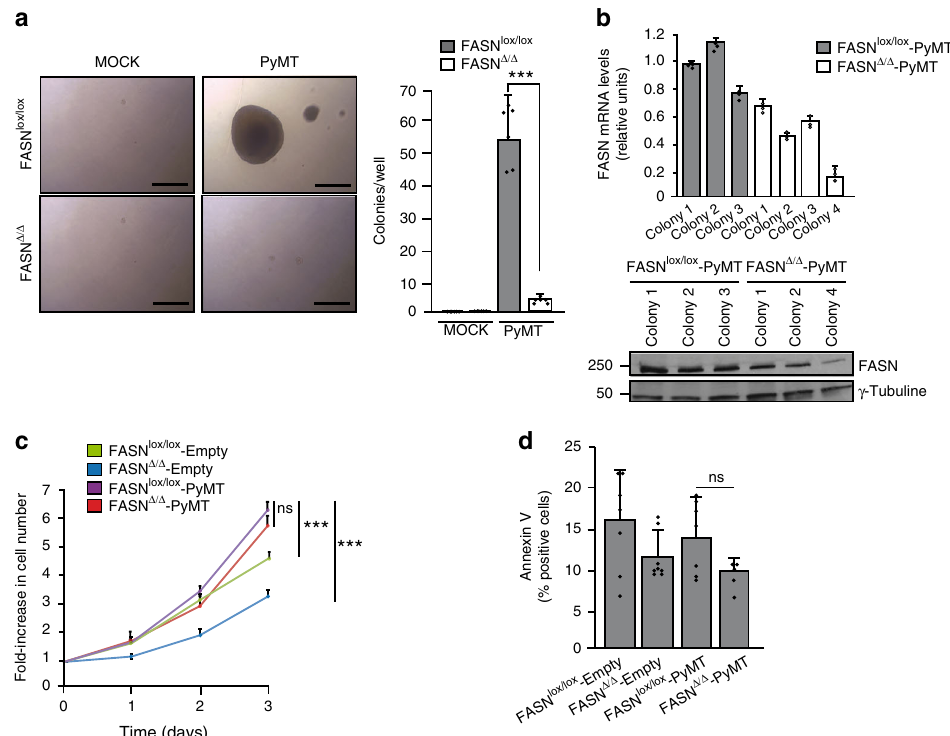
Fig. 1 FASN is essential for PyMT-dependent transformation in vitro. a Representative images of the soft agar colony assay and quantitation of colonies per well recovered from each of the four genotypes ( n = 6 biological replicates for each genotype). Scale bars, 500 μ M. b FASN mRNA and protein levels detected in soft agar colonies recovered from the FASN lox/lox -PyMT and FASN Δ / Δ -PyMT MEFs, respectively. c Cell replication rates after 1, 2, or 3 days for each genotype ( n = 3). Presented data are the mean values ± standard deviation (SD). *** P < 0.001; n.s., not statistically signi fi cant; Student ’ s t test. d Flow cytometry analysis of apoptosis. Percentages of cells in apoptosis are represented (FASN lox/lox -Empty, n = 7; FASN Δ / Δ -Empty, n = 8; FASN lox/lox -PyMT, n = 7; FASN Δ / Δ -PyMT, n = 5). Presented data are the mean values± standard deviation